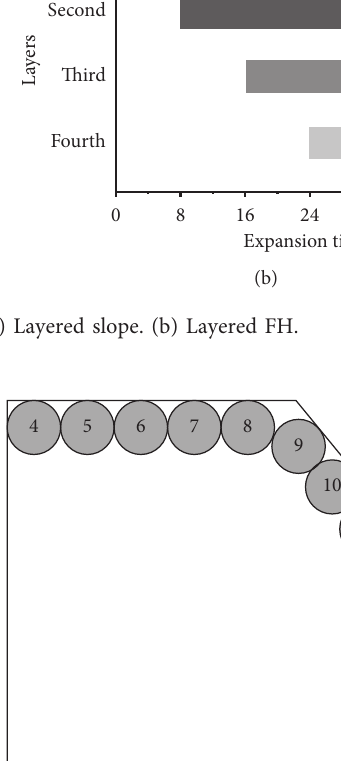
Figure 7: Layout of measuring